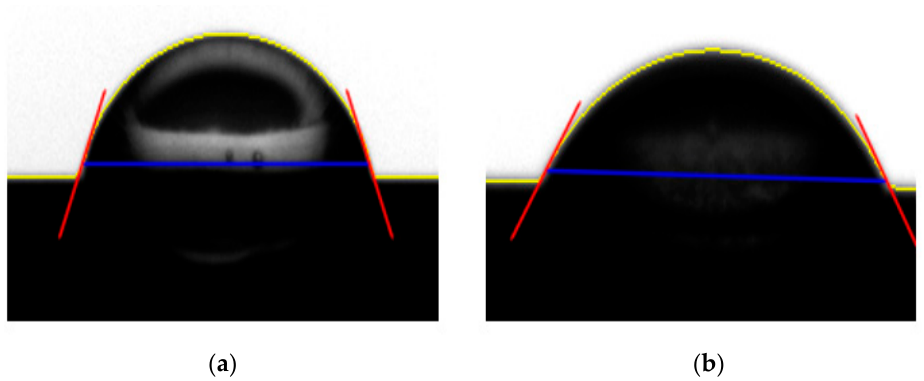
Figure 3. Contact angle of as-received specimen for; ( a ) Zr cladding ( θ = 66°); ( b ) CrAl-coated Zr cladding ( θ = 57°).